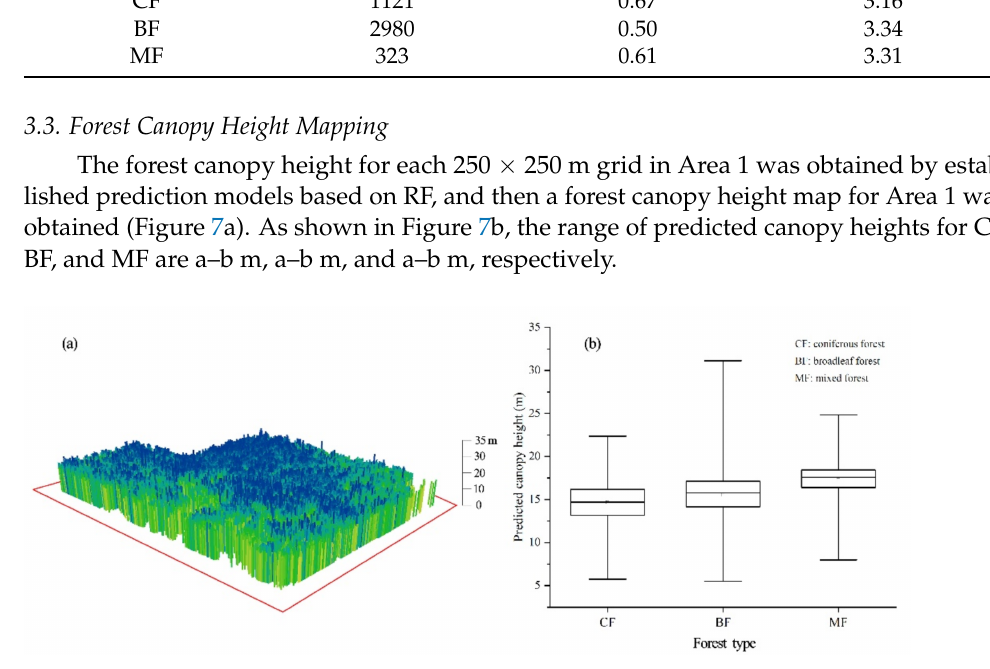
Figure 7. The 3D map of forest canopy height obtained by the RF method for Area 1 ( a ) and ranges of predicted canopy heights for CF, BF, and MF ( b